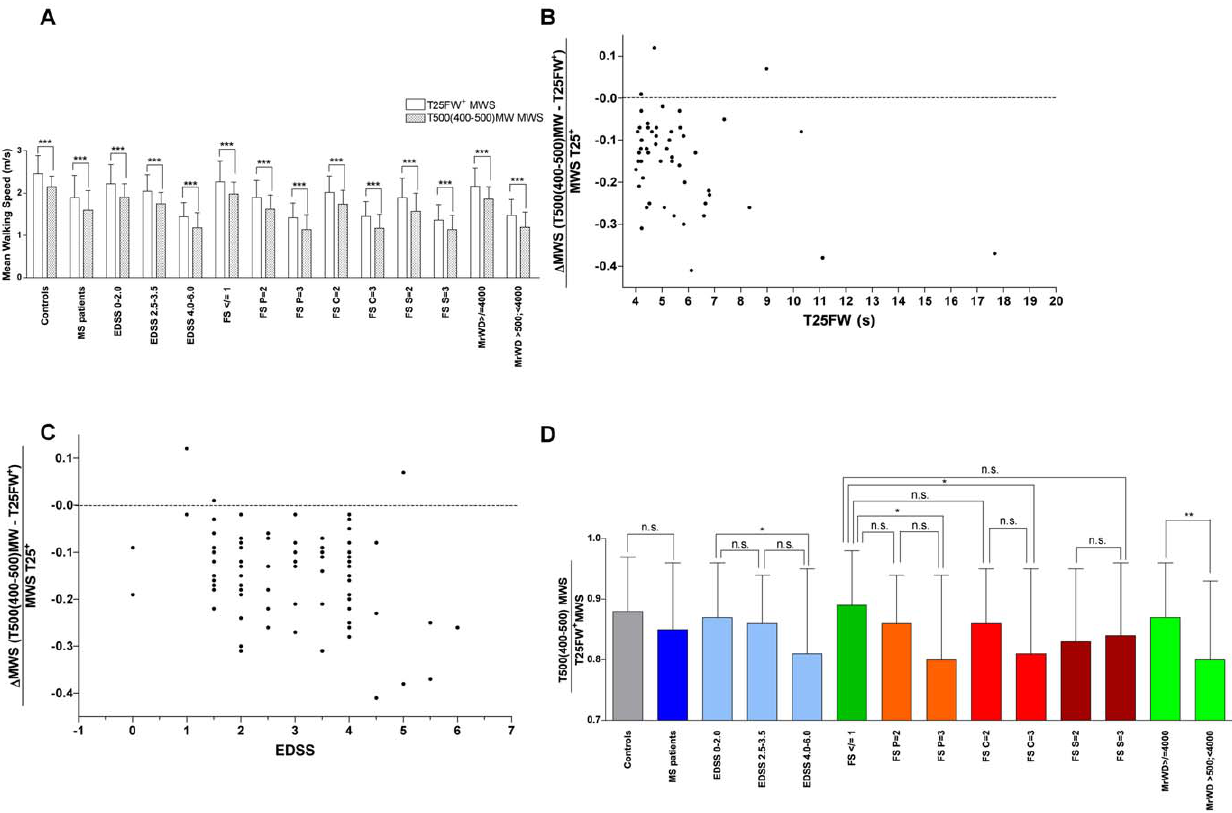
Figure 3. Quantification of ambulation fatigability through the Deceleration Index (DI). Ambulation fatigability was evaluated through the integration of the fastest (T25FW + ) and the lowest (T400–500MW) measurable WS, which were obviously highly statistically different in all pMS subgroups and healthy volunteers (A, all p , 0,0001). Absolute WS differences were however very similar between all groups (ranging from 0.22 m/s for FS S=3 to 0.31 m/s for EDSS 2.5–3.5 and Controls). This is why further comparisons between groups were focused on relative WS changes. No significant correlation could be found between the individual values of relative deceleration evaluated by the difference of MWS on the T25FW + and on the T400–500MW (expressed as percentage of the T25FW + MWS) and the level of walking impairment according to the T25FW (B) or the EDSS status (C). Deceleration Index (DI) calculated as the ratio between MWS of the T400–500MW divided by MWS of the T25FW + (D) in healthy volunteers and in different subgroups of the MS